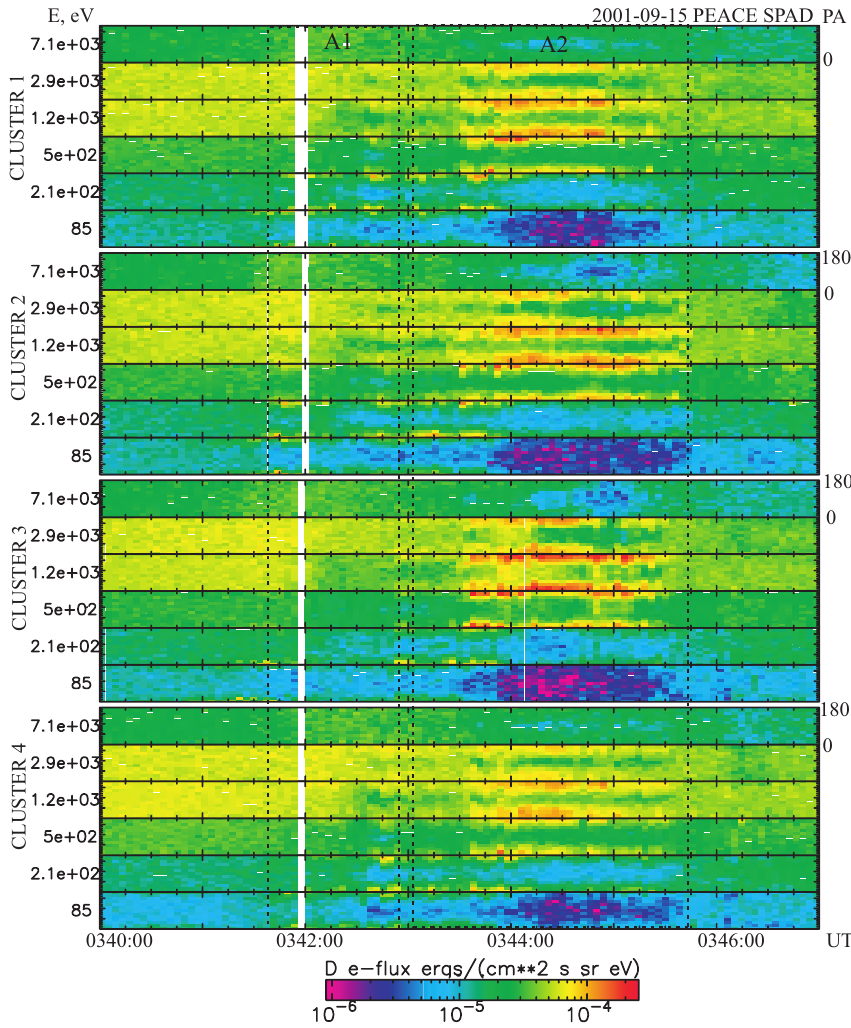
Fig. 5. Cluster PEACE pitch angle distribution (Spin PAD) energy-time spectrograms, interval A. Dashed line boxes show intervals A 1 and A